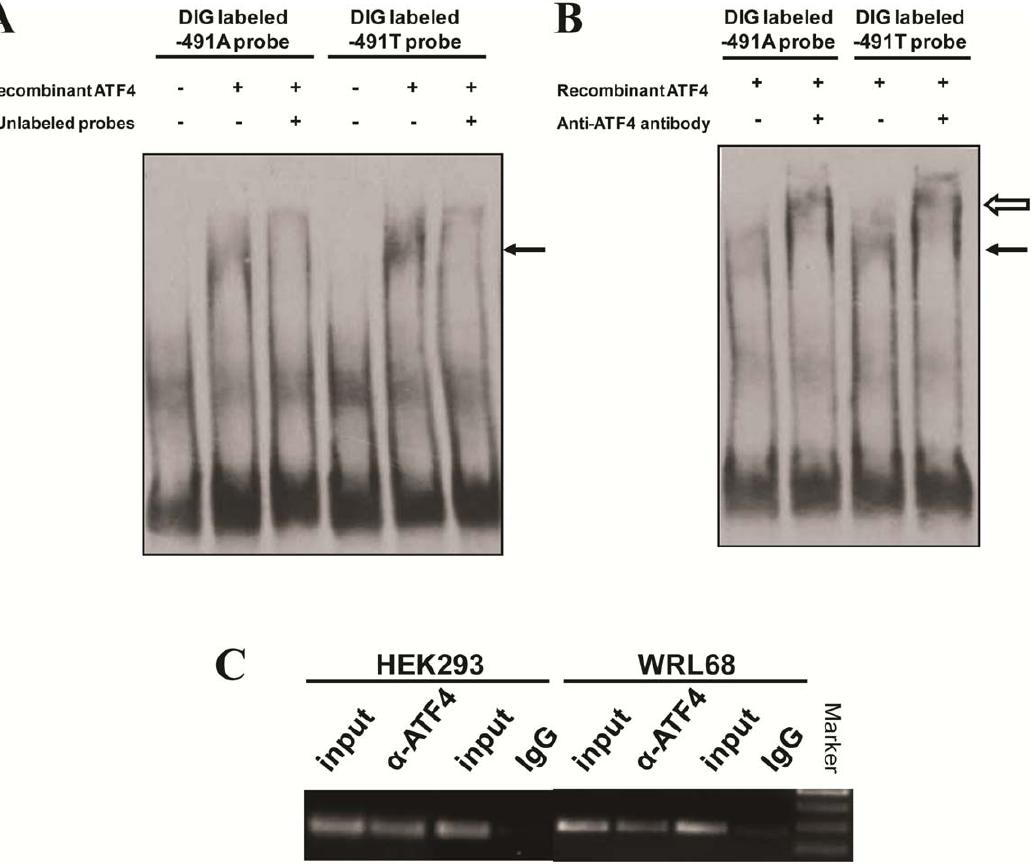
Figure 2. ATF4 physically interacts with APOE promoter 2 491-spanning region. (A) EMSA analyses were performed in 20 m l reaction system containing 3 nM of DIG-labeled 2 491A or 2 491T probe ( 2 521 to 2 461) 6 1.2 m M of the purified His-tagged ATF4 protein, the shift-bands are indicated by solid arrowhead. (B) Super-shift assays are performed by the addition of ATF4 antibody into reaction mixture containing 2 491A or 2 491T probes and 0.7 m M purified ATF4 protein. The super-shift bands are indicated by unfilled arrowhead. (C) Chromatin Immunoprecipitation (ChIP) assays confirmed the in vivo interaction of APOE promoter 2 491-spanning sequence and ATF4 in 293 ( 2 491AA genotype) and WRL68 ( 2 491TT genotype) cells.